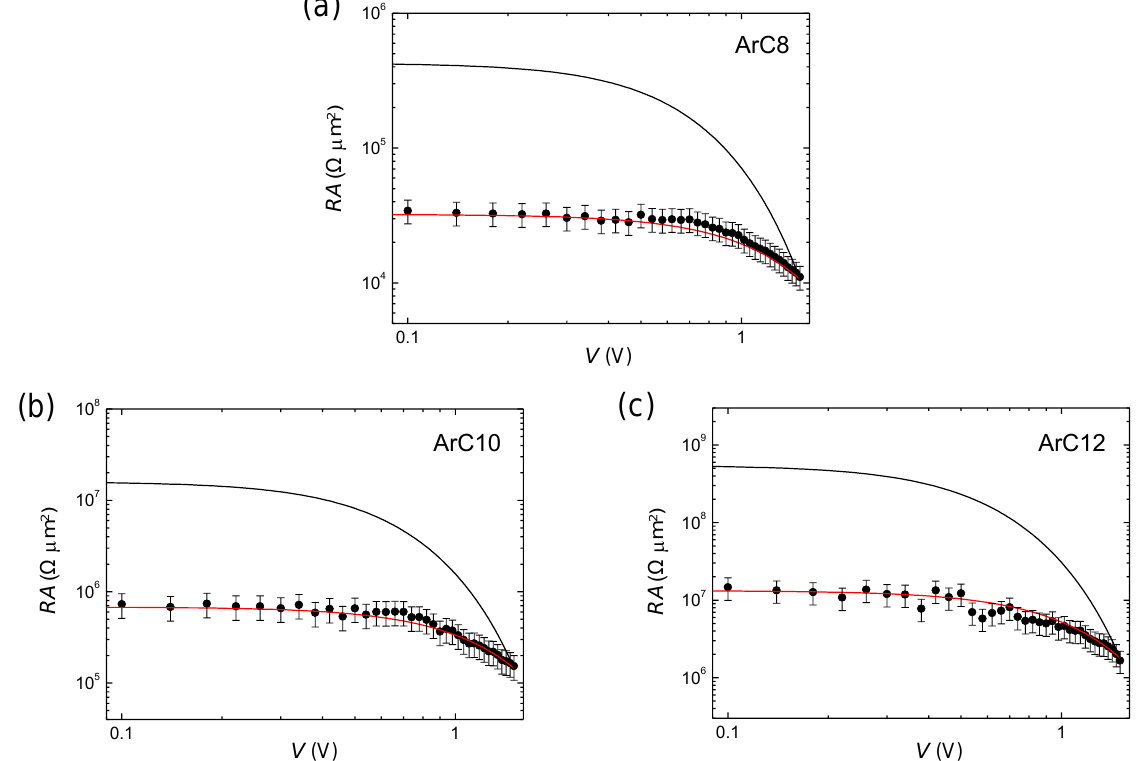
Figure 5. Log plots of RA versus V for ( a ) ArC8, ( b ) ArC10, and ( c ) ArC12 junctions. The fits with the original Simmons model for a constant barrier height (black curves) and the simulation of the VIBL-modified Simmons model (red curves) are